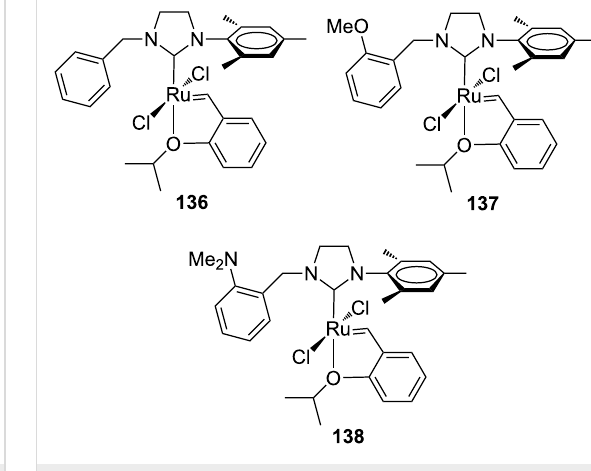
Figure 25: Hoveyda-type complexes 136–138 with N -benzyl, N’ -mesityl NHCs.